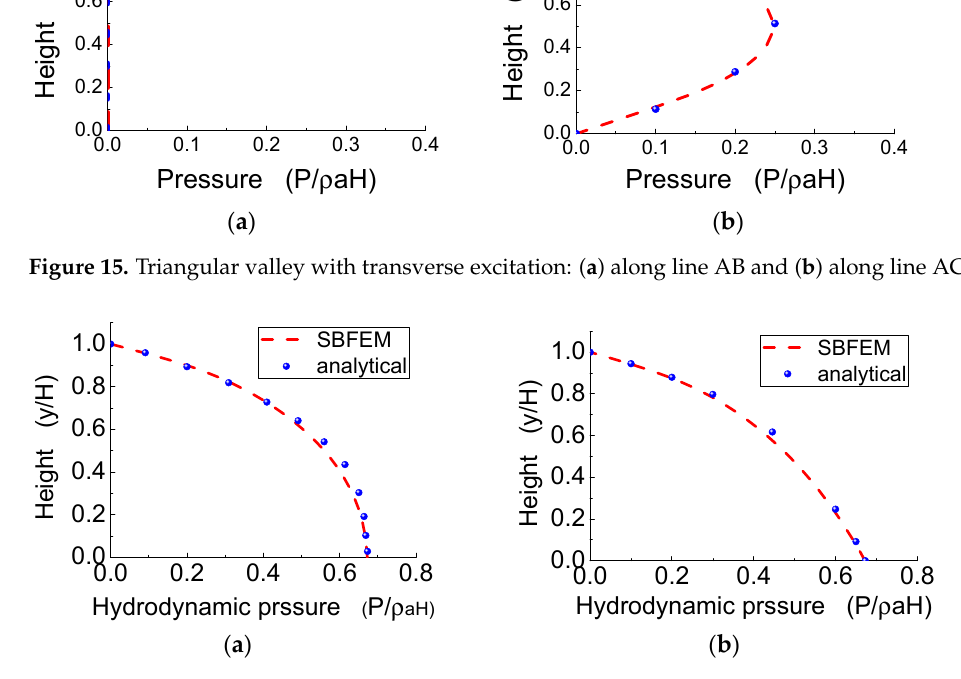
( b ) Figure 17. Semicircular valley with vertical excitation: ( a ) along line AB and ( b ) along line BC. ( a ) ( b ) Figure 18. Semicircular valley with transverse excitation: ( a ) along line AB and ( b ) along line BC. Moreover, the proposed method has a high efficiency, because only 2D discretization was required to simulate the 3D semi-infinite reservoir water. Therefore, the proposed hydrodynamic pressure method can serve as a convenient analysis tool for further estab- lishing a dynamic coupling analysis method for the dam–reservoir systems when polyhe- dral solid elements are utilized to build cross-scale models of dams. 5. Dynamic Coupling Analysis of Nonlinear Cross-Scale CFRD and Reservoir Sys- tems With the polyhedron SBFEM for solid and fluid being used to discretize the CFRD and reservoir, the elasto-plastic cross-scale dynamic coupling analysis was conducted to investigate the effect of hydrodynamic pressure on the dynamic response of CFRD. The